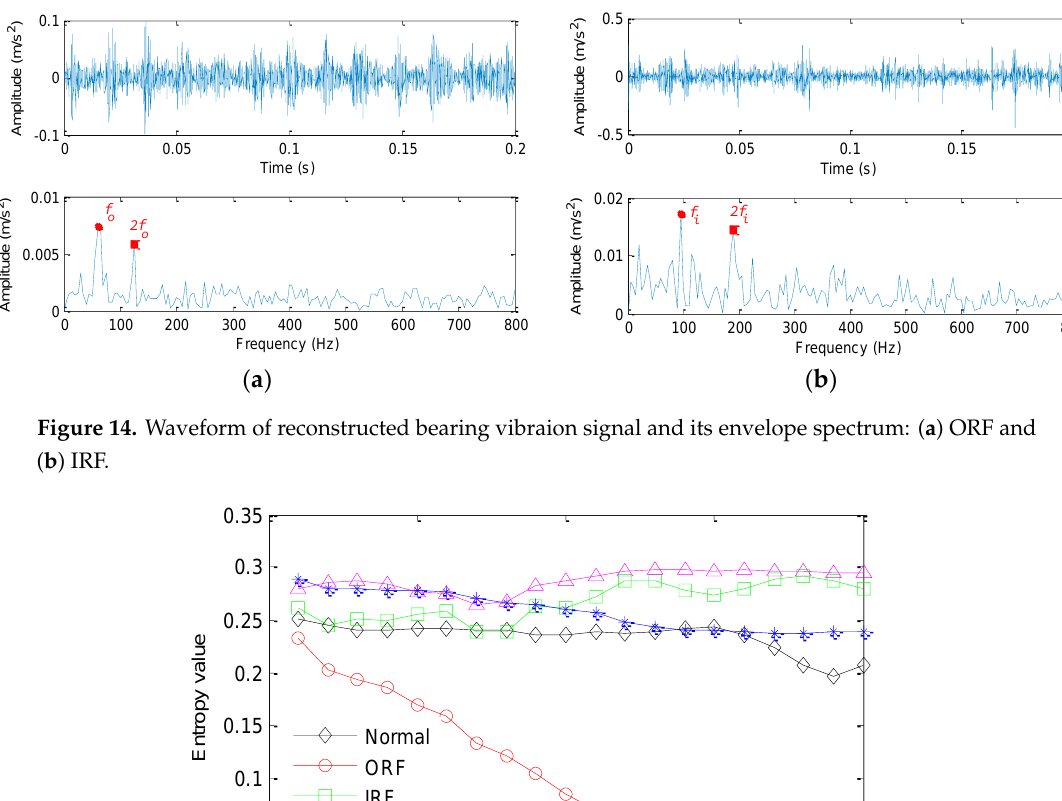
Figure 13. Decomposition results obtained by SGMD for bearing vibraion signal: ( a ) ORF and ( b ) IRF.